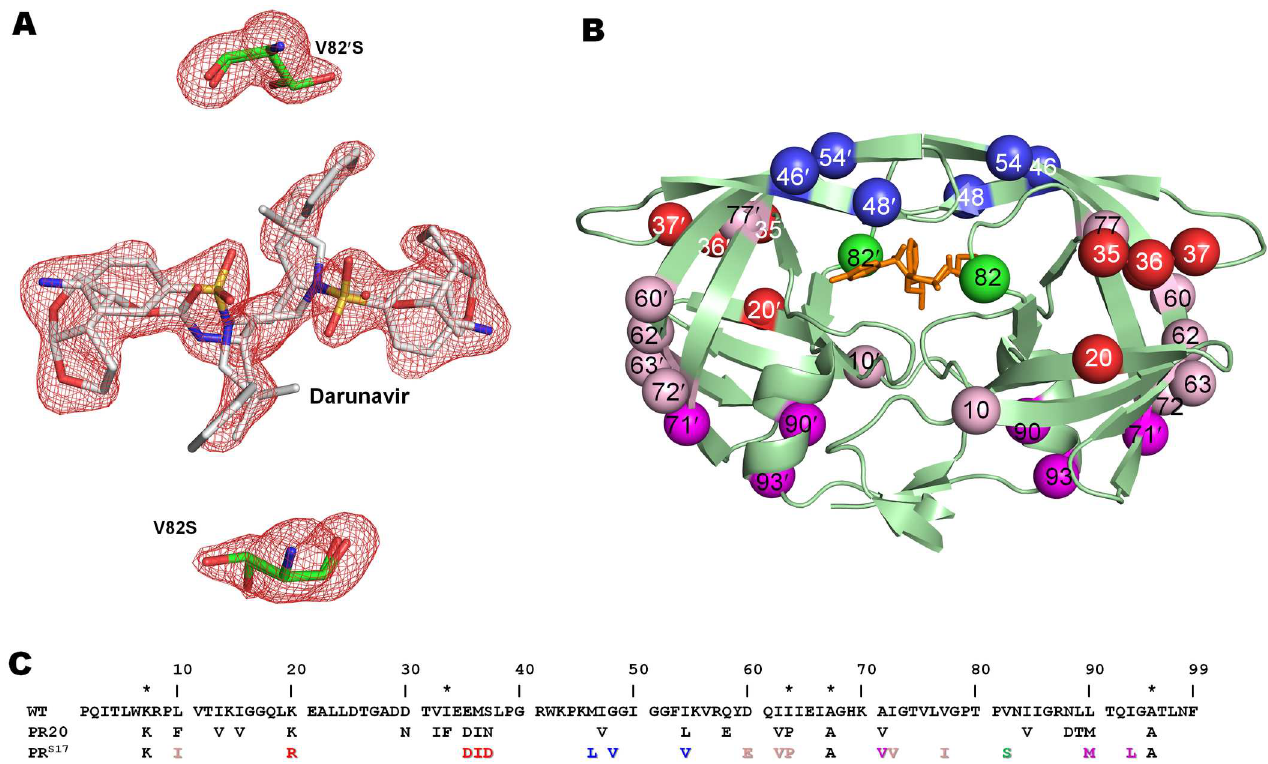
Fig 1. Two Alternate Conformations of Darunavir and the Active Site Mutation V82S in PR S17 /DRV Dimer. A. F o -F c omit map contouredat 3 σ level shows Ser82 and DRV have two alternate conformations in both subunits. B. Sites of 17 mutations are mappedon PR S17 (pale green cartoon representation) with bound DRV shown as orangesticks. V82S mutation, proximalto the active site, is shown as a green sphere in each subunit. The mutations in the hinge loop cluster are colored as red sphereswhilethe flap mutation cluster is representedas blue spheres. Note that K20R interacts with residuesin the hinge loop althoughit is not contiguous in sequencewith this regionas describedlater. The distal mutations perturbing active site aspartates are colored as magentaspheresand remainingmutationsare shownas pink spheres. C. Sequencealignment of PR S17 with PR and PR20. Mutations introduced in WT PR to restrict autoproteolysis (Q7K, L33I and L63I) and avoid cysteine-thiol oxidation(C67A and C95A) are indictedby asterisks. Residuesidenticalto PR in PR20 and PR S17 are omitted. The 17 mutations of PR S17 are colored similar to